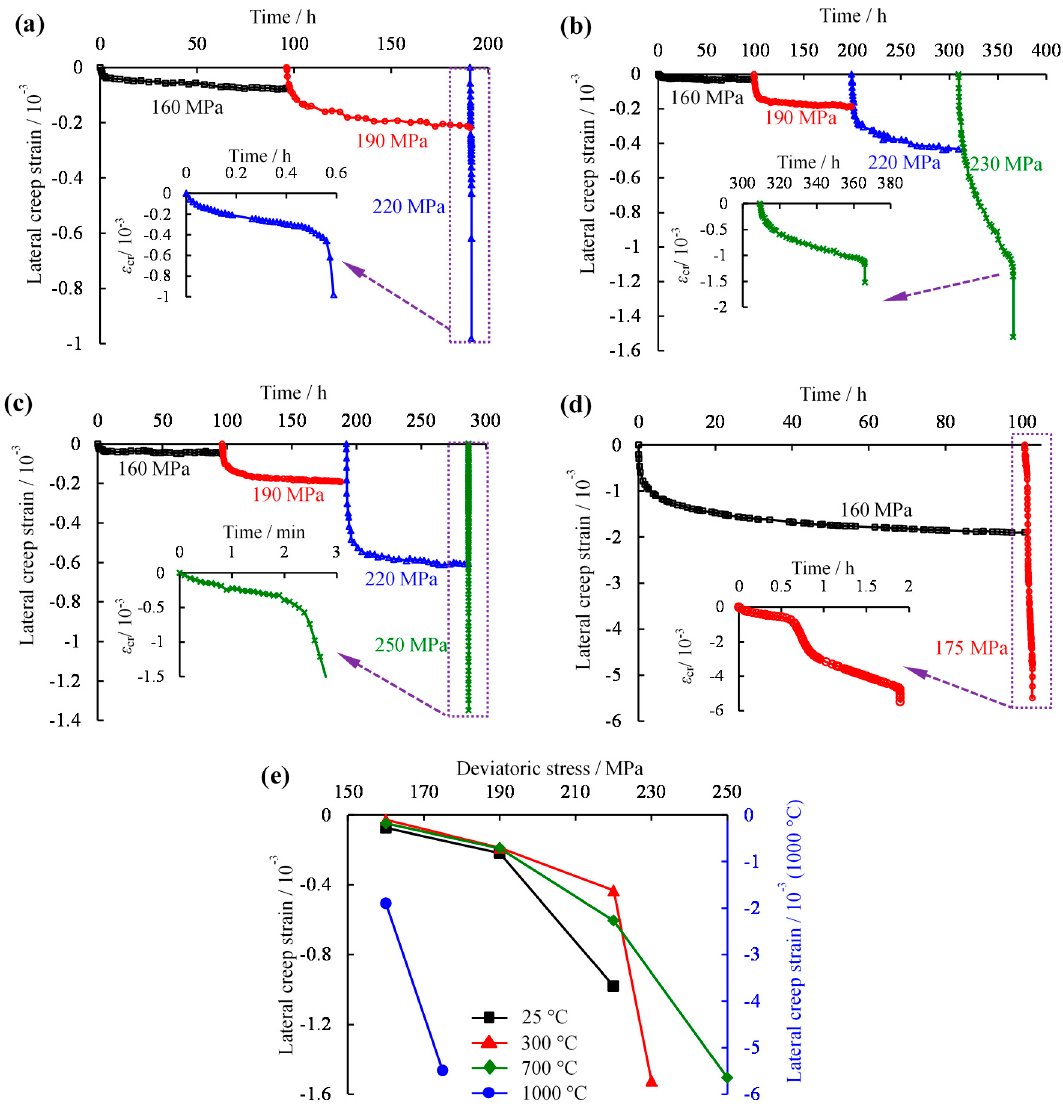
Figure 5. Lateral creep strain-time curves under step-loading at different temperatures ( σ 3 = 25 MPa): ( a ) 25 °C; ( b ) 300 °C; ( c ) 700 °C; ( d ) 1000 °C; ( e ) Relationship between lateral creep strain and deviatoric stress. Energies 2018 , 11 , 212